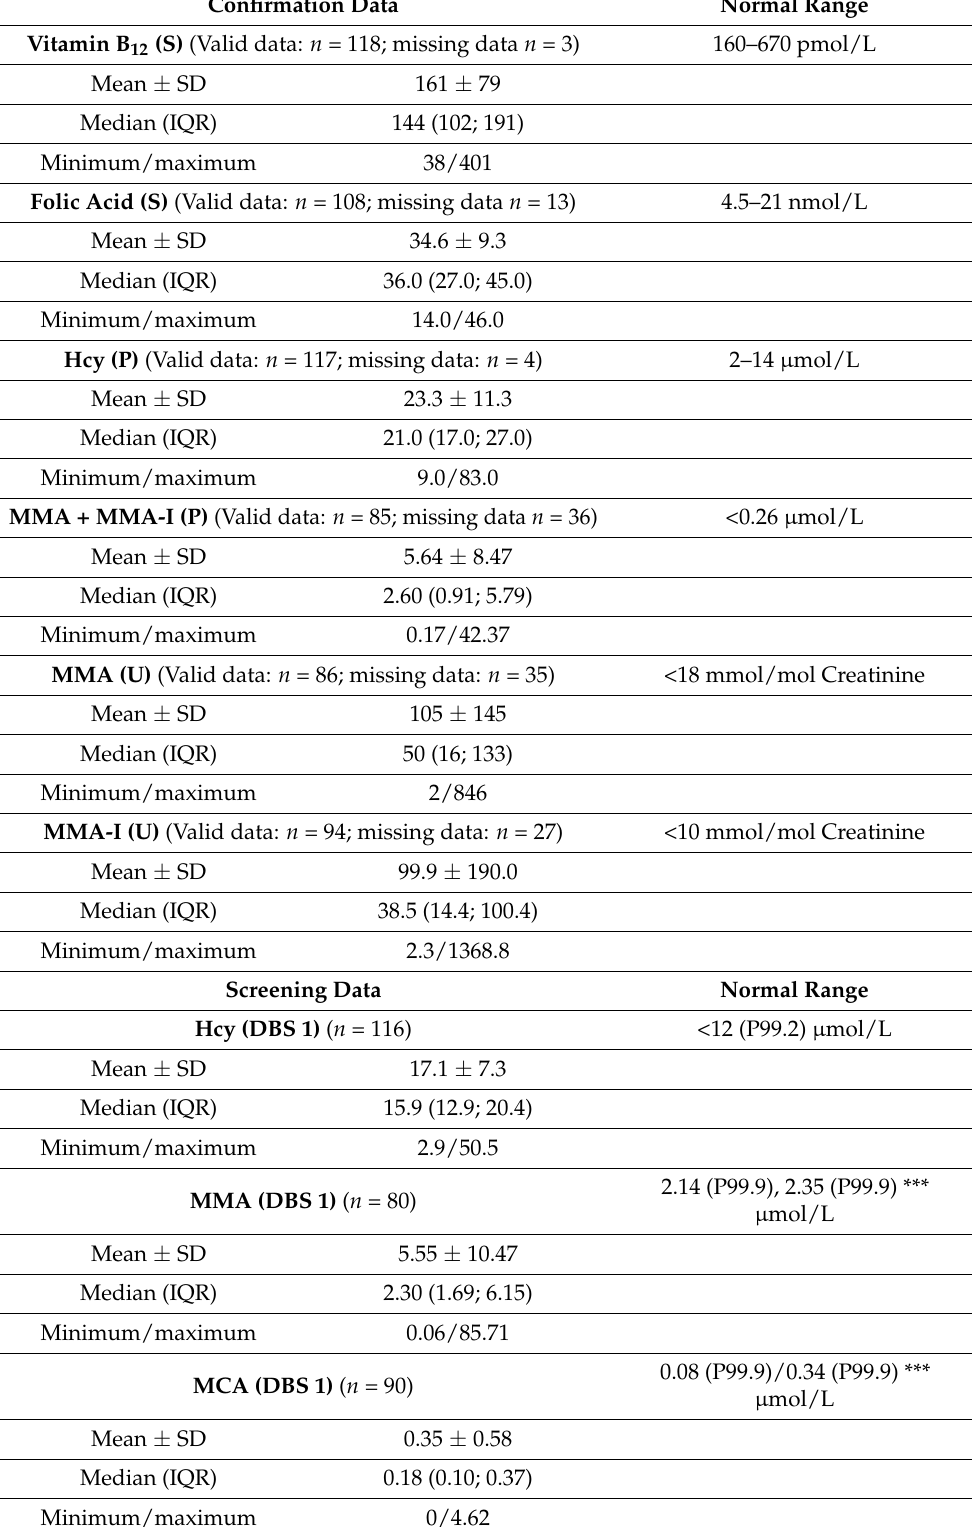
Table 3. Newborns’ vitamin B 12